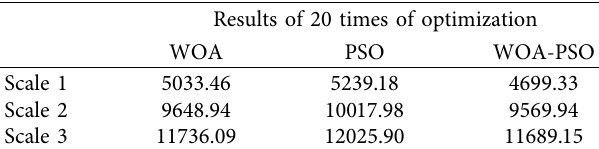
Table 2: Optimization result comparison among different algorithms.